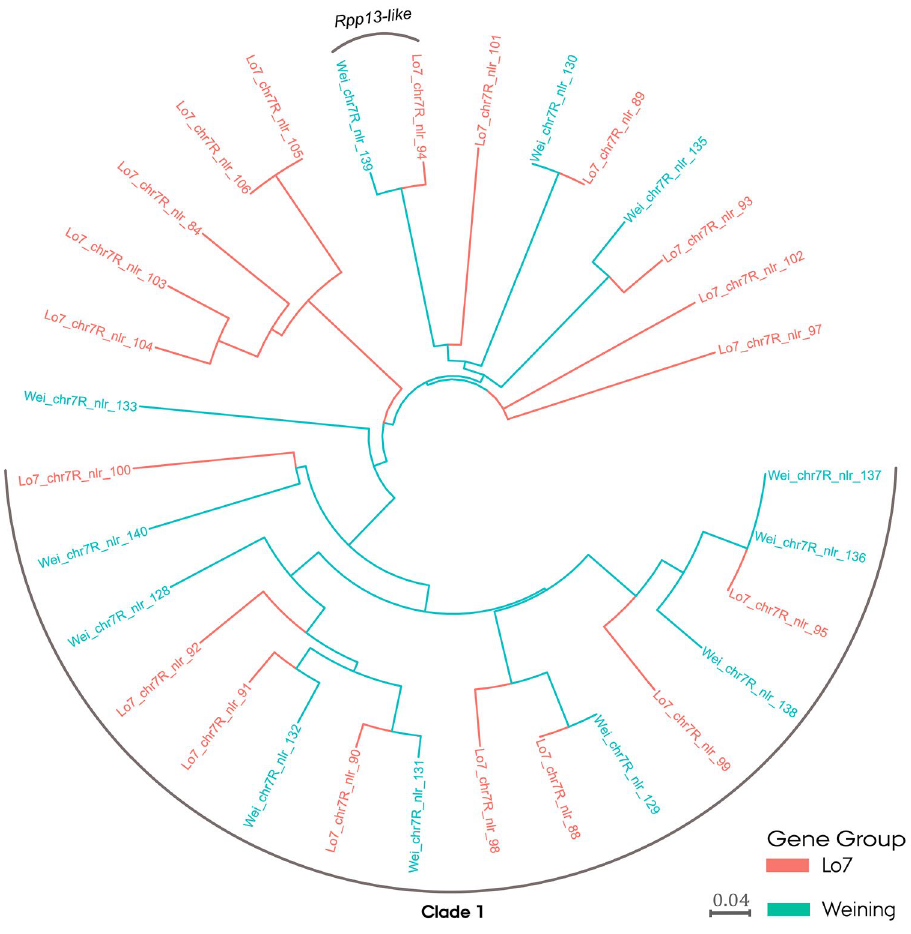
Figure 5. Phylogenetic tree of nucleotide-binding leucine-rich repeat (NLR) protein NB-ARC domains in the ‘Weining’ and ‘Lo7’ rye ( Secale cereale L.) reference genomes. NLR genes are located at a powdery mildew resistance-associated site in the subtelomeric region of chromosome arm